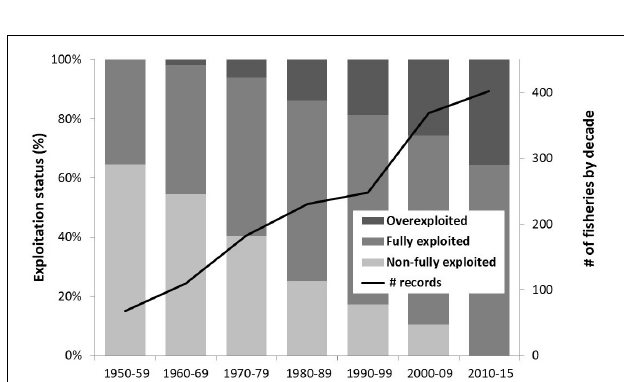
FIGURE 8 | Exploitation status evolution of snapper and grouper fisheries and number of fisheries considered over the decades based on the FAO’s global capture fisheries dataset (FAO,